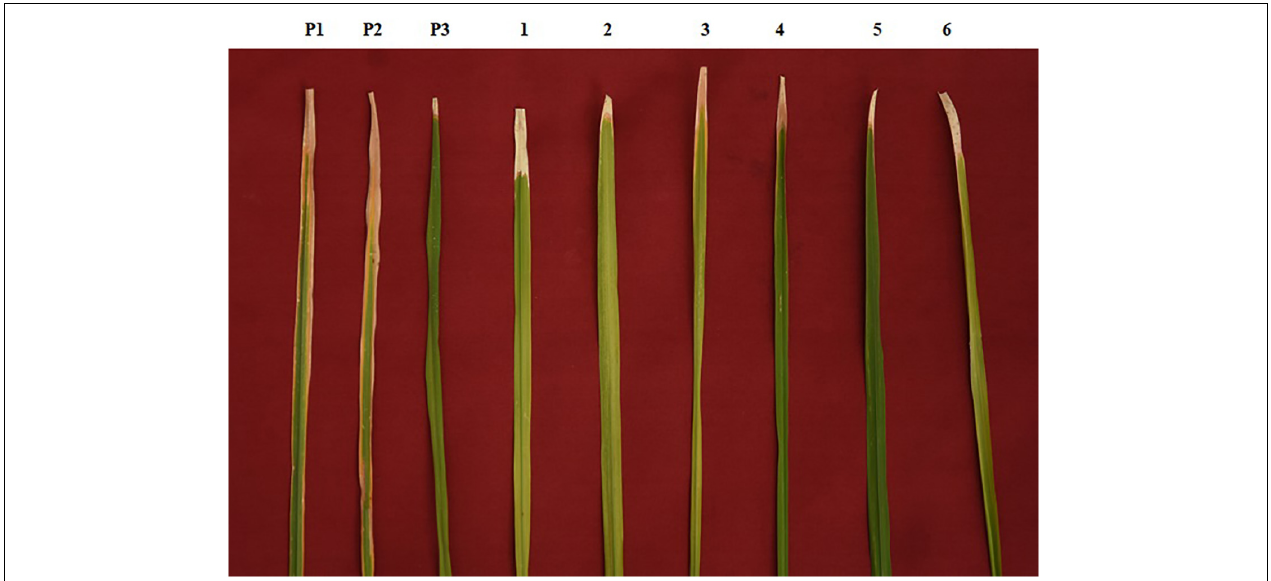
FIGURE 2 | Phenotypic screening of improved pyramided lines against DX-027 isolate of bacterial blight (BB). P1 – ASD 16, P2 – ADT 43, P3 – IRBB60; serially numbered 1, 2, 3, 4, 5, and 6 lines indicate improved pyramided lines of recurrent parents harboring xa5 , xa13 , and Xa21 genes.